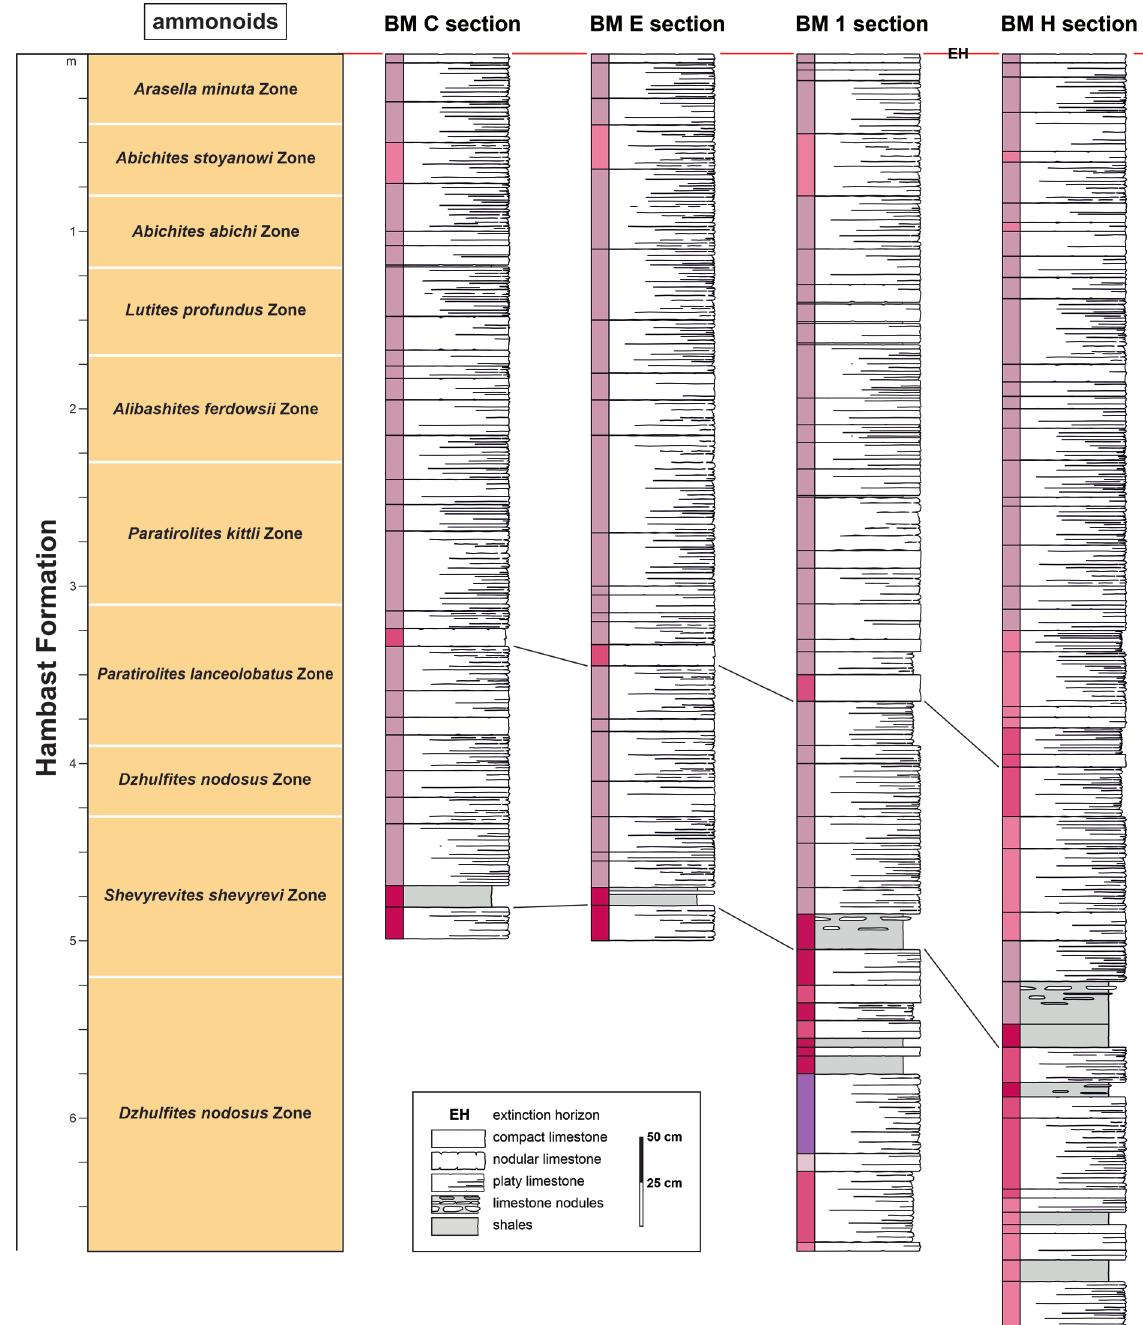
Fig. 3. Four selected columnar sections of the upper part of the Hambast Formation ( Paratirolites Limestone equivalent) at Baghuk Mountain with their ammonoid